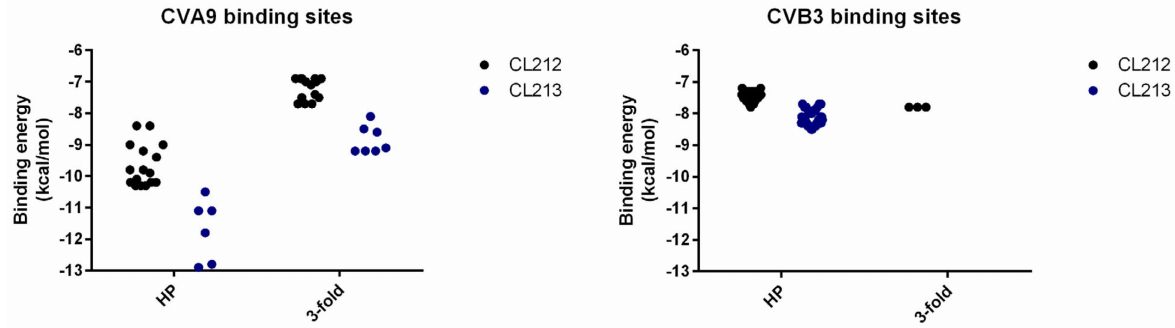
Figure 10. The binding energies of CL212 and CL213 docking poses across CVA9 and CVB3 capsids. The data are presented from two regions: hydrophobic pocket (HP) and 3-fold axis pore (3-fold). Each dot represents one experimental unit, a docking